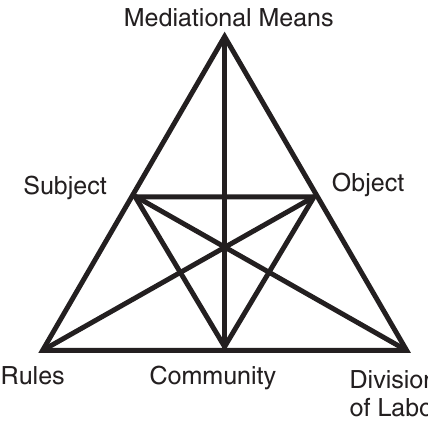
FIG. 1. Generalized cultural-historical activity triangle, as used in Refs. [12,33,37], and this work. Lines between each aspect of the triangle indicate interactions that mediate the activity of the subject either directly or